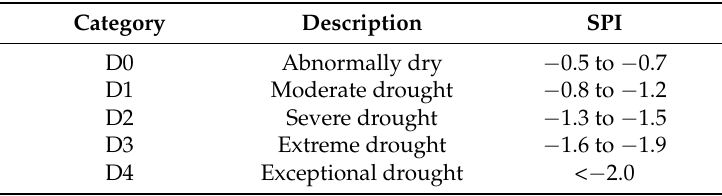
Table 2. Classification of drought severity